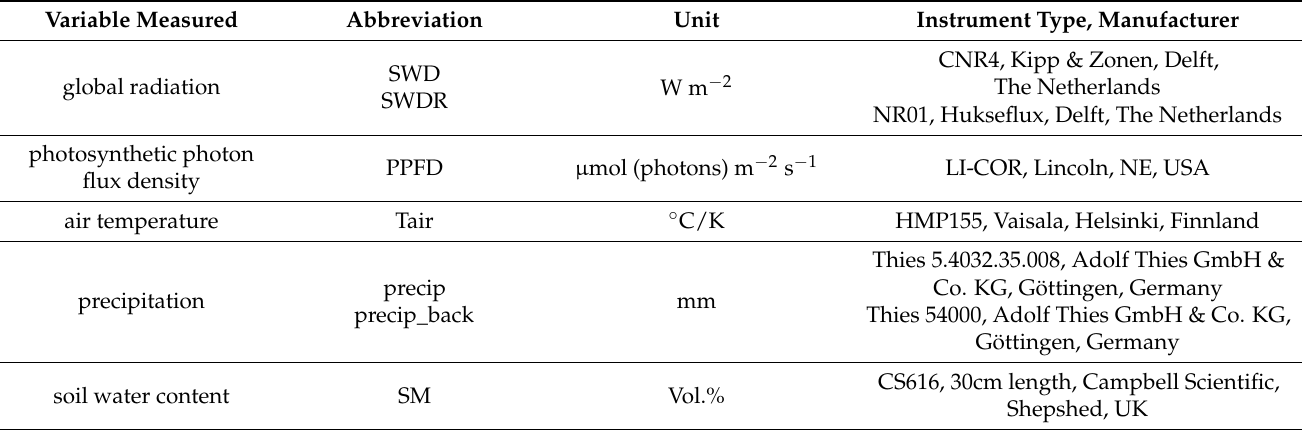
Table A1. Main abiotic variables measured at the EC tower in 33 m (air temperature), and 49 m (radiation and precipitation), and in 0.4 m soil depth (soil moisture) needed as input for the forest model